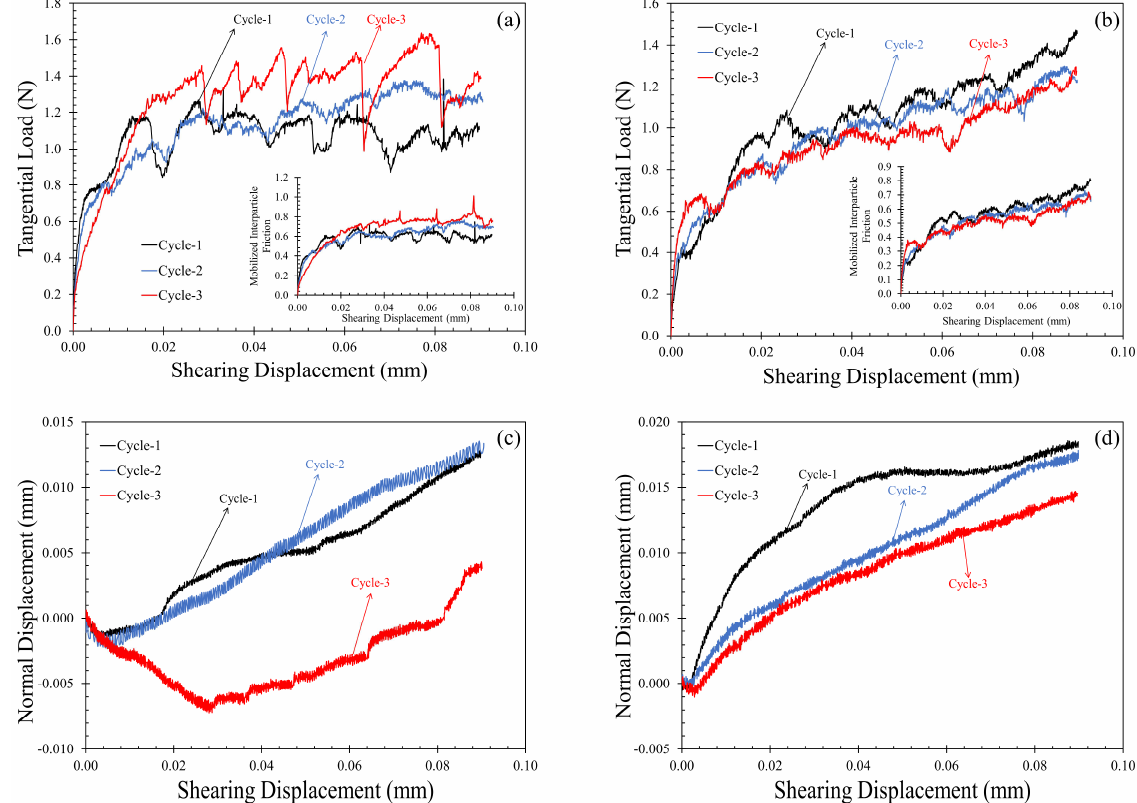
Figure 10. Tangential contact response of MMS-1 for three cycles of repeated monotonic loading for two cases of MMS-1 specimens showing opposite trends: ( a – b ) tangential load-displacement curves (insets: mobilized friction versus tangential displacement) and ( c – d ) normal displacement versus shearing displacement curves.